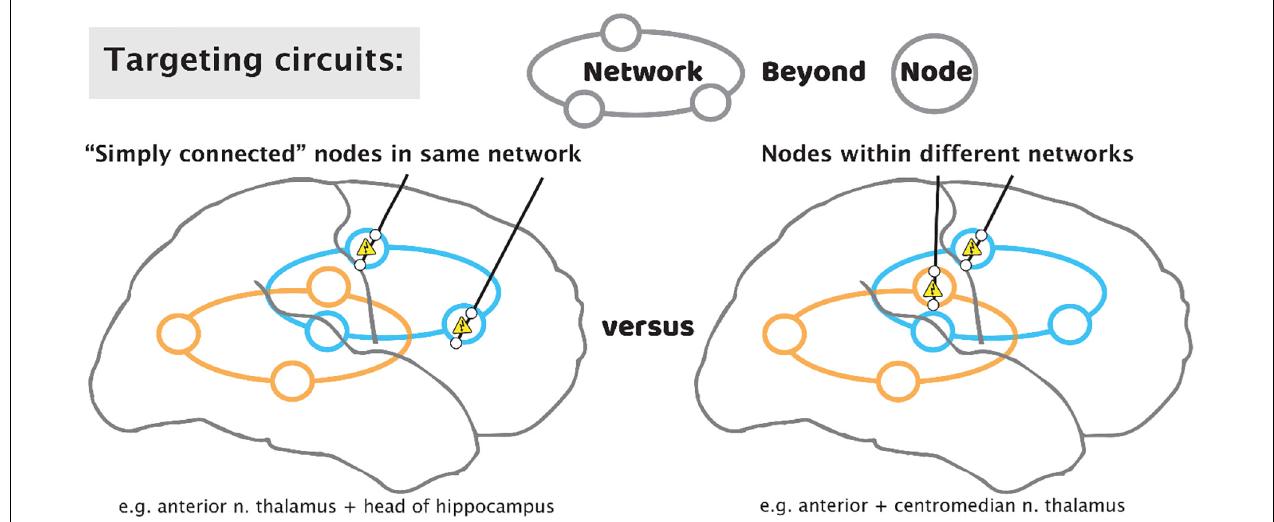
FIGURE 10 | Targeting circuits with stimulating leads for epilepsy. As we move beyond a paradigm that focuses solely on the seizure focus, approaches may include targeting of multiple “simply connected” nodes in the same network (left) , or tandem nodes within different networks (right) .